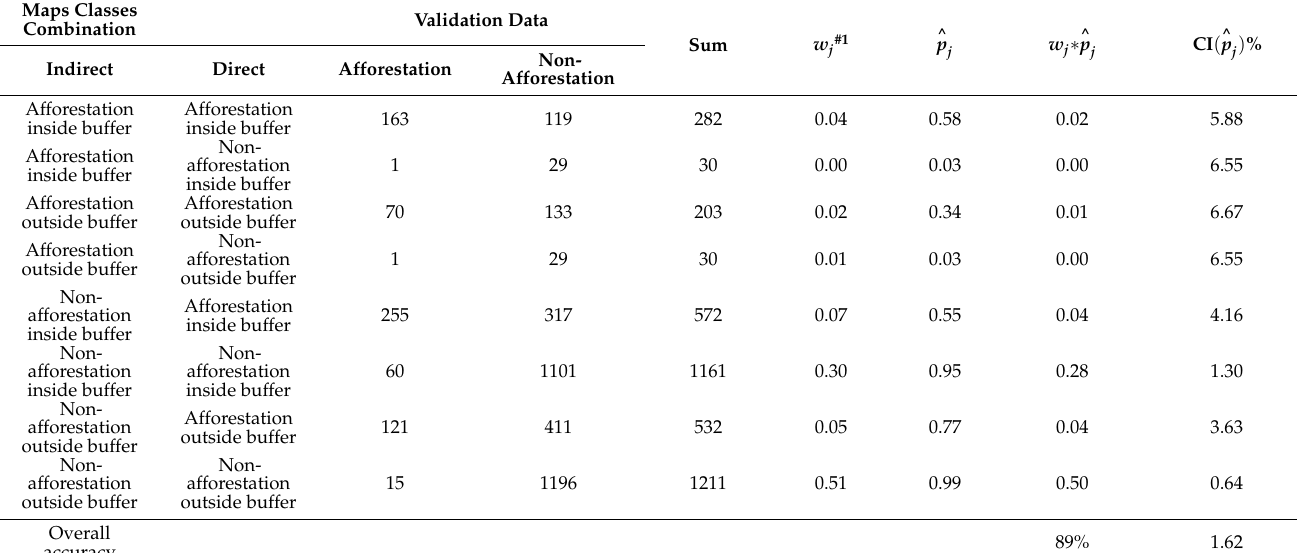
Table A2. Overall accuracy assessment for indirect map. Results of Table 3 calculations.